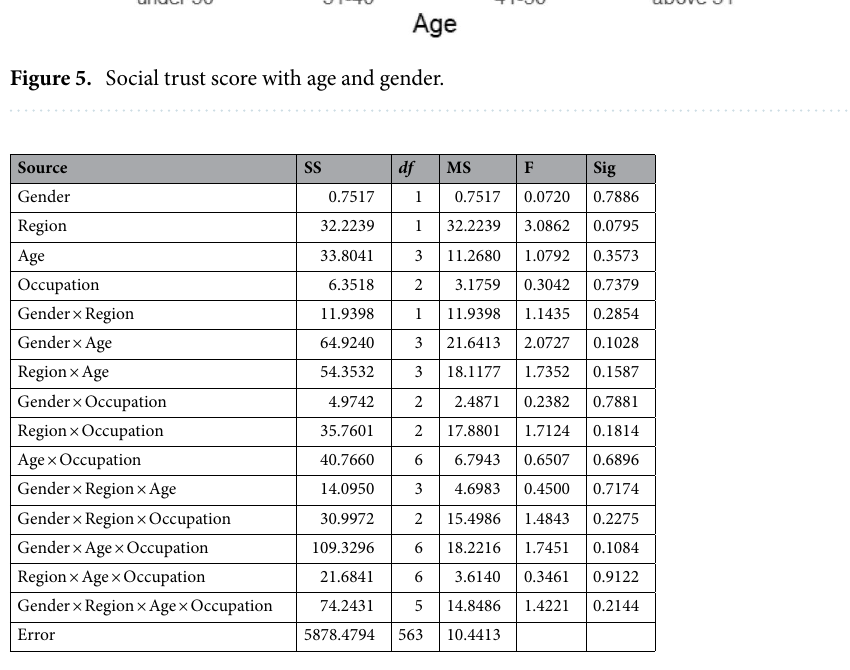
Table 7. Four-way Analysis of information credibility with gender, region, age and